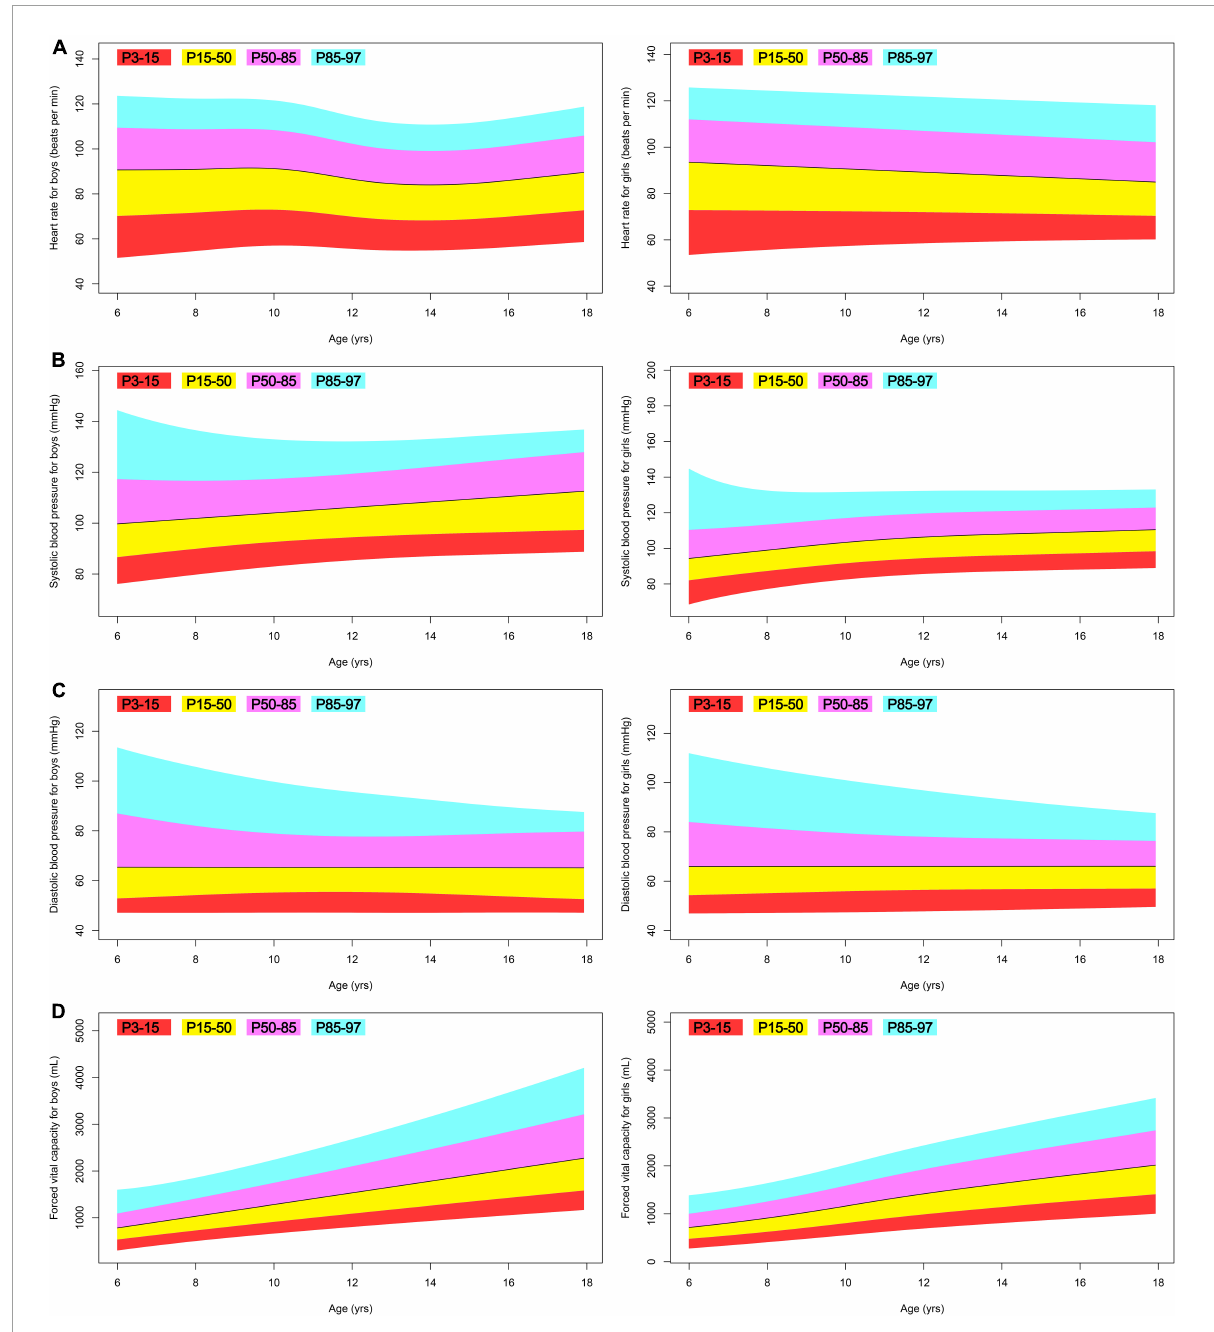
FIGURE4 Fan plot displaying the 3, 15, 50, 85, and 97% centiles for the body function of Tibetan ethnic children aged 6–17. (A) Heart rate; (B) systolic blood pressure; (C) diastolic blood pressure; (D) forced vital